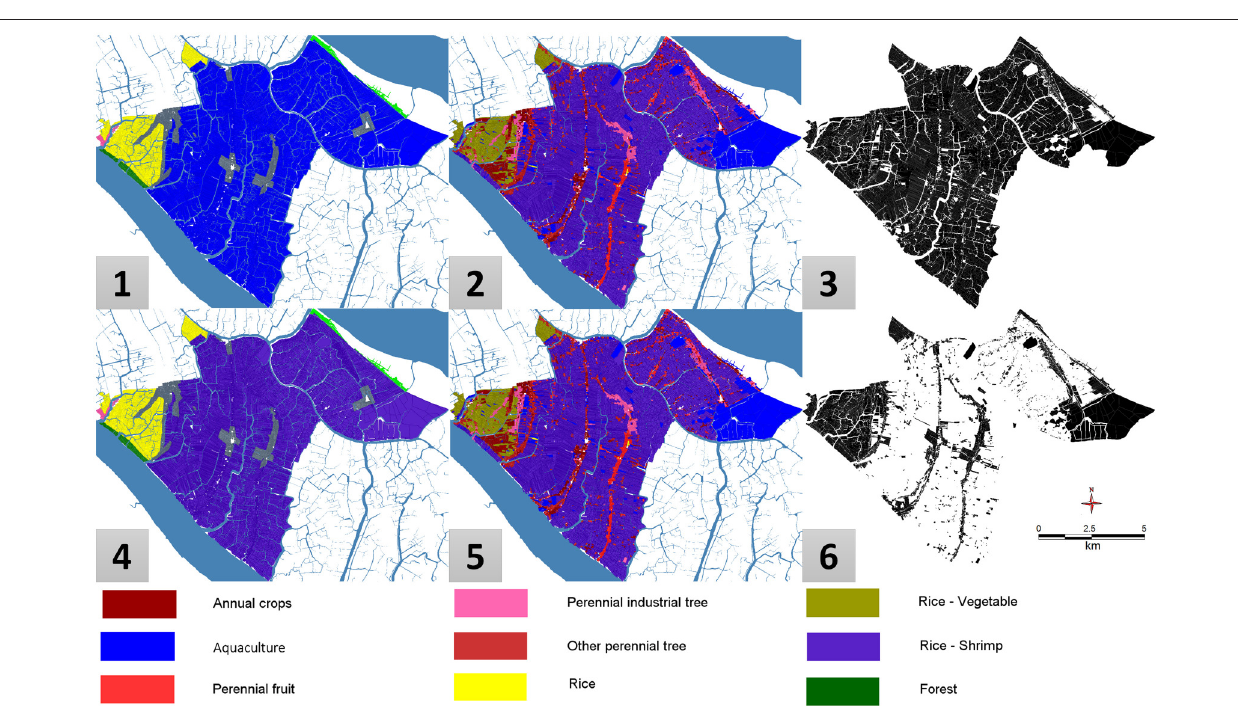
FIGURE 4 | Comparison of land-use planning map and land-use map in 2010 of 5 villages of Thanh Phu district, Ben Tre province. (1) Land-use planning map 2010 (planned in 2001), (4) Land-use planning map 2010 (modified in 2005), (2), (5) Land-use map in 2010, (3) Fuzzy Kappa map between 1 and 2, (6) Fuzzy Kappa map between 4 and